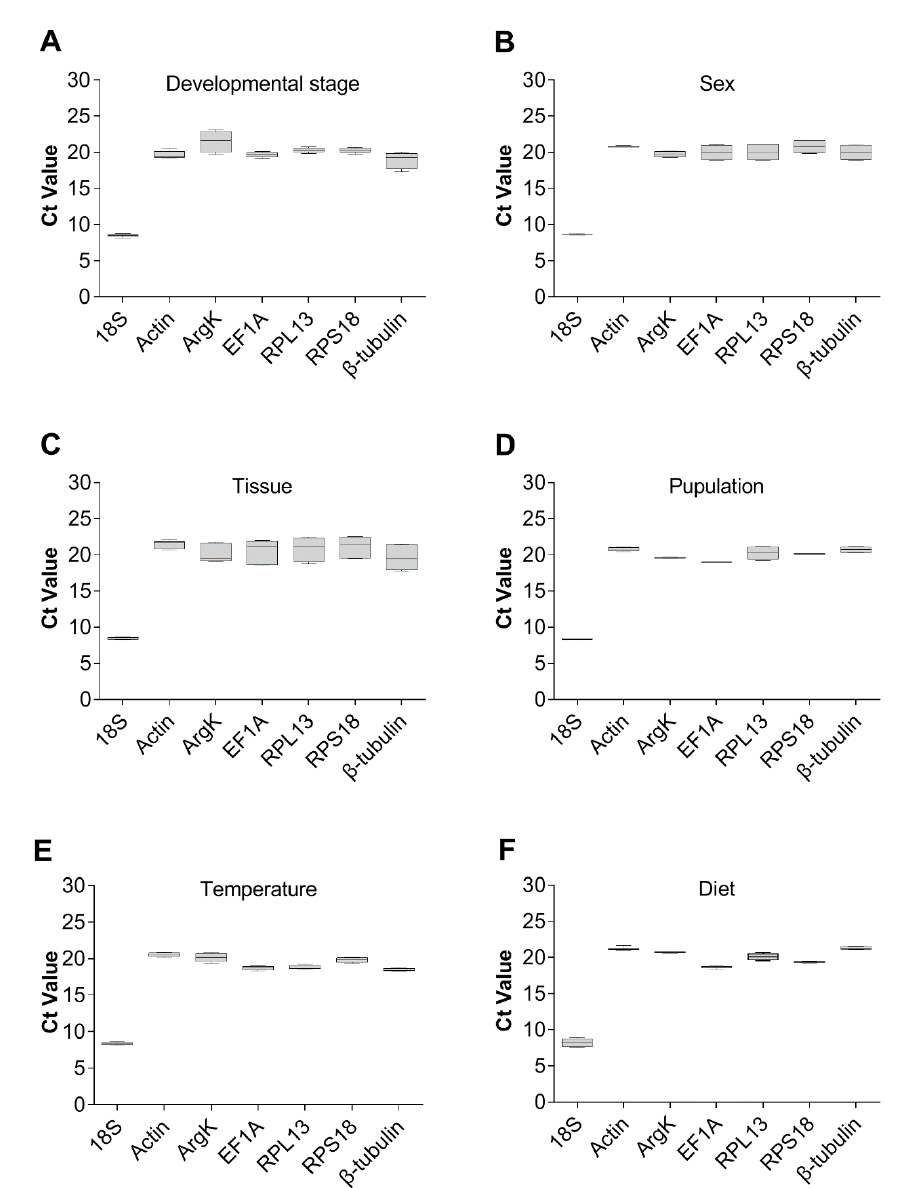
Figure 4. Expression profiles of the seven candidate reference genes in all six experiments for T. radiata . The expression levels of the reference genes are shown in terms of the Ct-value for each experimental condition. ( A ) Developmental stage, ( B ) sex, ( C ) tissue, ( D ) population, ( E ) temperature, and ( F ) diet.